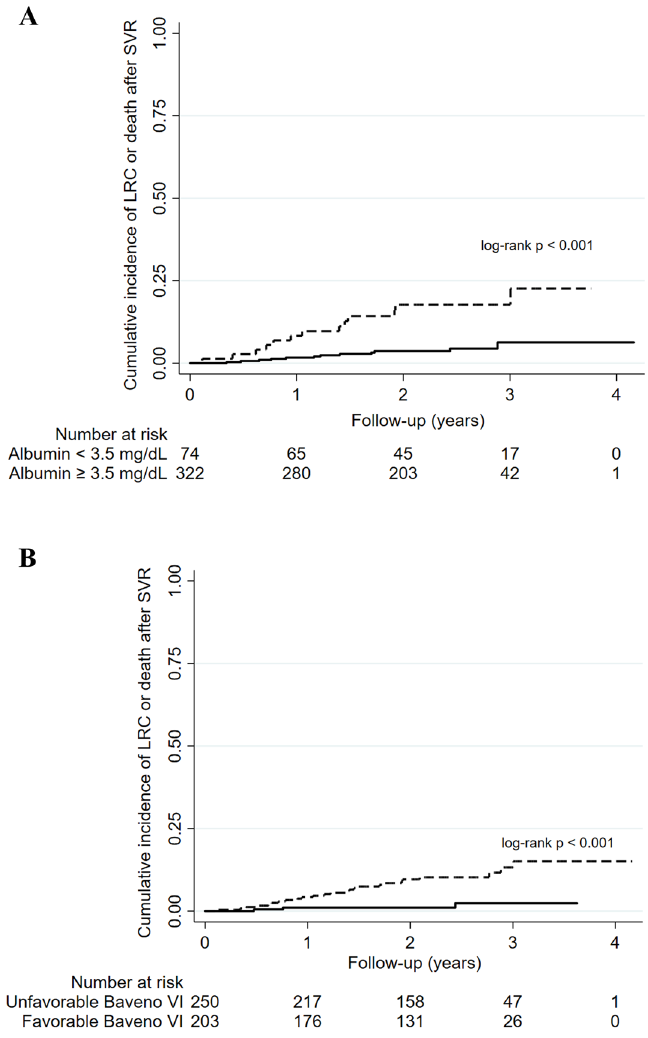
Figure 2. Cumulative incidence of liver related complications or death according to characteristics before HCV treatment ( A ) albumin levels (< 3.5 mg/dL vs. ≥ 3.5 mg/dL) and ( B ) Baveno VI status (unfavorable vs favorable) [all log-rank tests]; SVR sustained virological